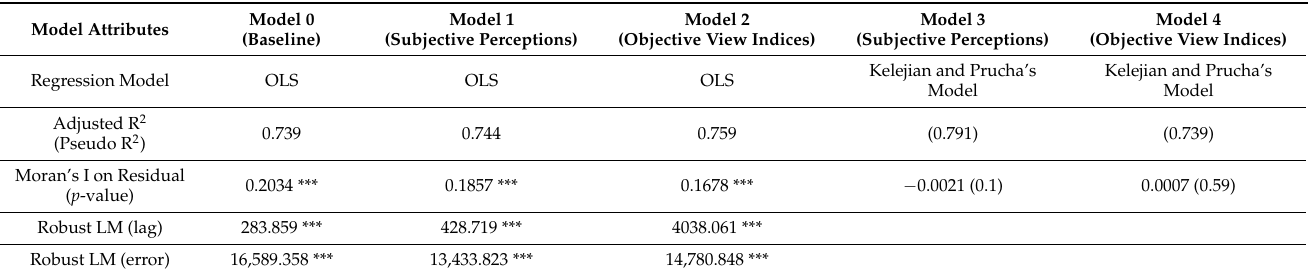
Table 2. Regression performance and diagnosis for all